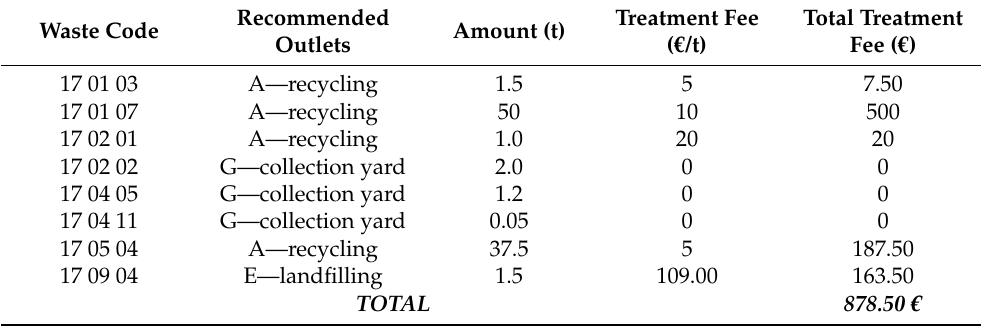
Table 10. Economic analysis of waste management according to CDW recommendation—variant A.